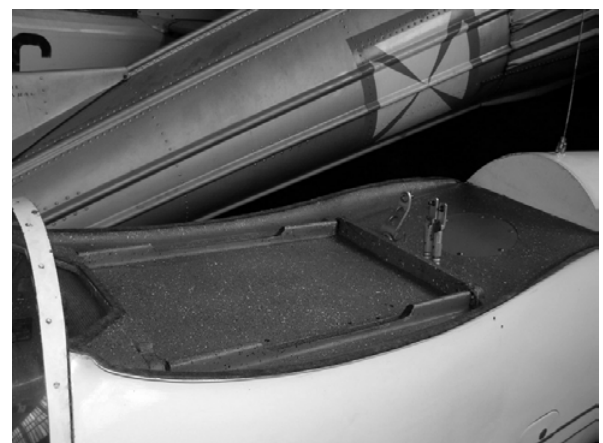
Fig 16. Clasps for attaching pins in fuselage centre section